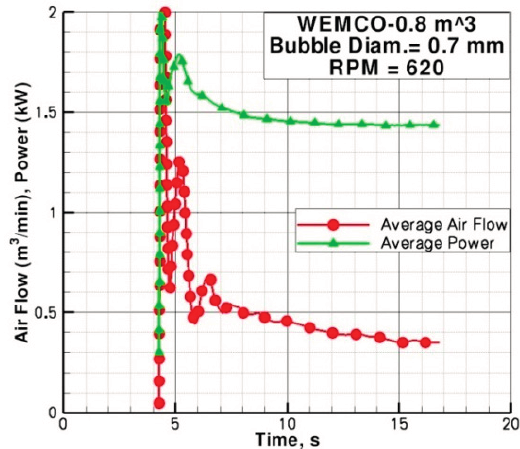
Figure 5. Running average of air flow rate and